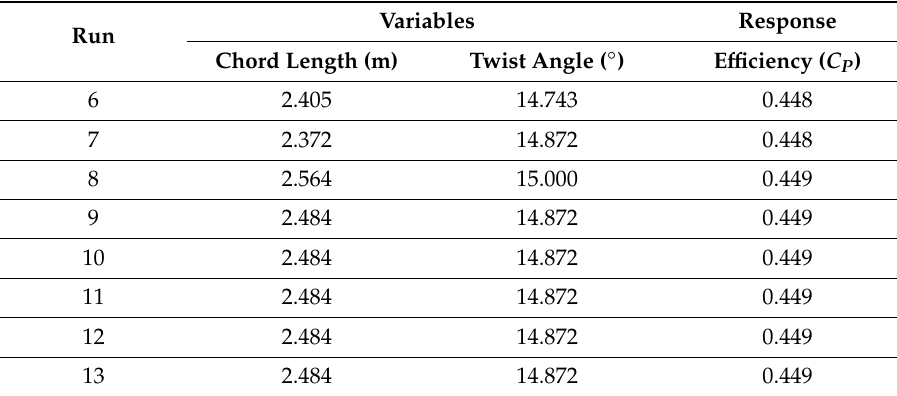
Table 4. Design of the parameters for calculation location